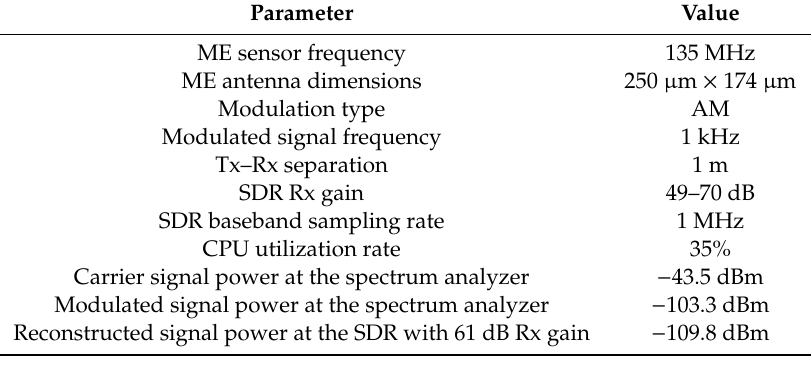
Table 1. SDR receiver parameters and measurement results.